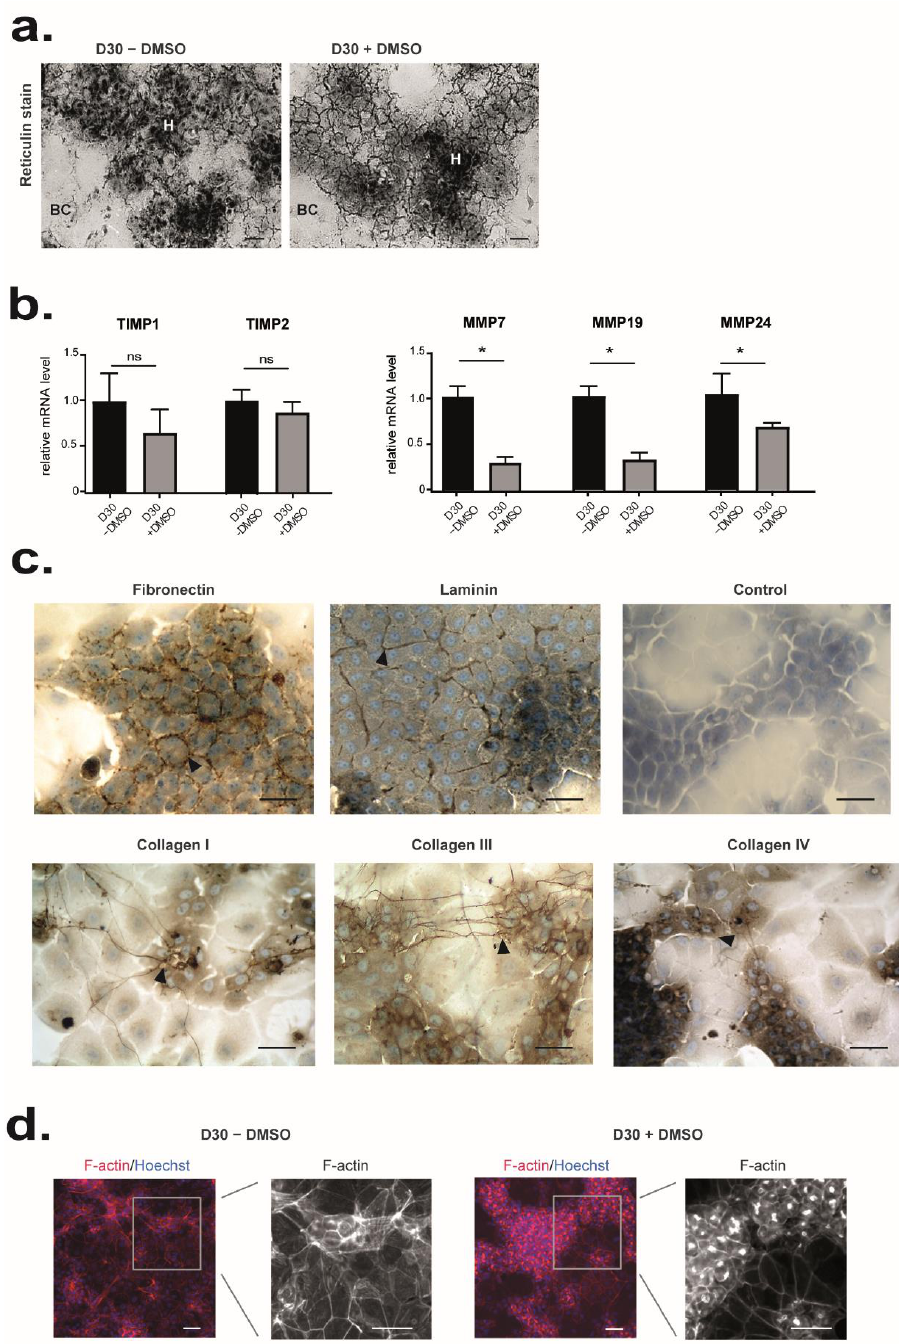
Figure 3. Effects of DMSO on matrix remodeling and cell organization. ( a ) ECM deposition was detected by reticulin staining on HepaRG cells differentiated from D15 of culture in the presence (D30+ DMSO) or the absence of DMSO ( D30 − DMSO ). ( b ) Microarray data for TIMP1, TIMP2, MMP7, MMP19, and MMP24 are expressed relative to conditions D30 − DMSO, arbitrary set to 1. The significance of DMSO treatment (D30 + DMSO vs D30 − DMSO ) was evaluated by an unpaired t -test * p < 0.05, ns: not significant. ( c ) Immunostaining of fibronectin, laminin, collagen type I, III, and IV in HepaRG cells differentiated in the presence of DMSO (D30+ DMSO). Immunolocalization without primary antibody was performed as control. ( d ) Immunolocalization of F-actin in HepaRG cells differentiated from D15 of culture in the presence (D30+ DMSO, left panel) or in the absence of DMSO (D30 − DMSO, right panel). Nuclei were visualized by staining with Hoechst (shown in blue). Scale bars = 7 µ